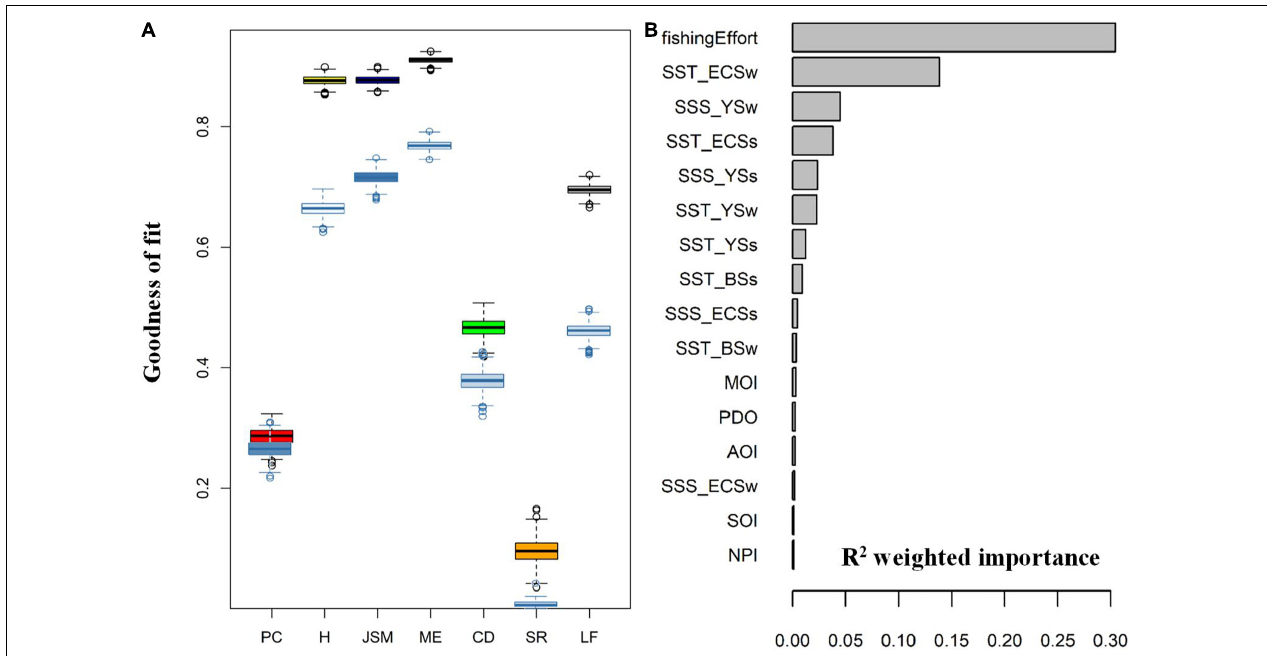
FIGURE 8 | (A) Goodness-of-fit R 2 of the gradient forest analysis for seven Chinese piscivorous fish with PC, H, ME, JSM, CD, SR, and LF representing Pacific cod, hairtail, marine eel, Japanese-Spanish mackerel, common dolphinfish, sharks and ray, and lizardfish, respectively, whereas GF results with no fishing effort were showed in nattier blue; (B) the mean importance of each variable weighted by species R 2 , including fishing effort, various climatic indices (PDO: Pacific Decadal Oscillation, NPI: North Pacific Index, AOI: Arctic Oscillation Index, SOI: Southern Oscillation Index, and MOI: Asian Monsoon Index) and sea surface temperature (SST) data in different seas and seasons (BSs, Bohai Sea summer; BSw, Bohai Sea winter; YSs, Yellow Sea summer; YSw, Yellow Sea winter; ECSs, East China Sea summer; ECSw, East China Sea winter).